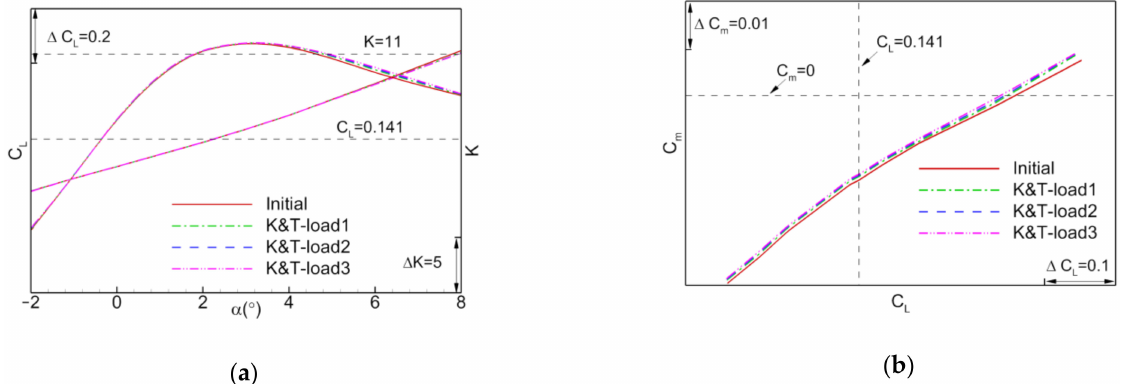
Figure 24. Aerodynamic characteristic of the configurations with different fore-loading kink and tip airfoils. Ma = 0.85, H = 11 km, α = − 2 ◦ ∼ 8 ◦ , ∆ α = 2 ◦ . ( a ) Lift coefficient, lift to drag ratio; ( b ) Pitching